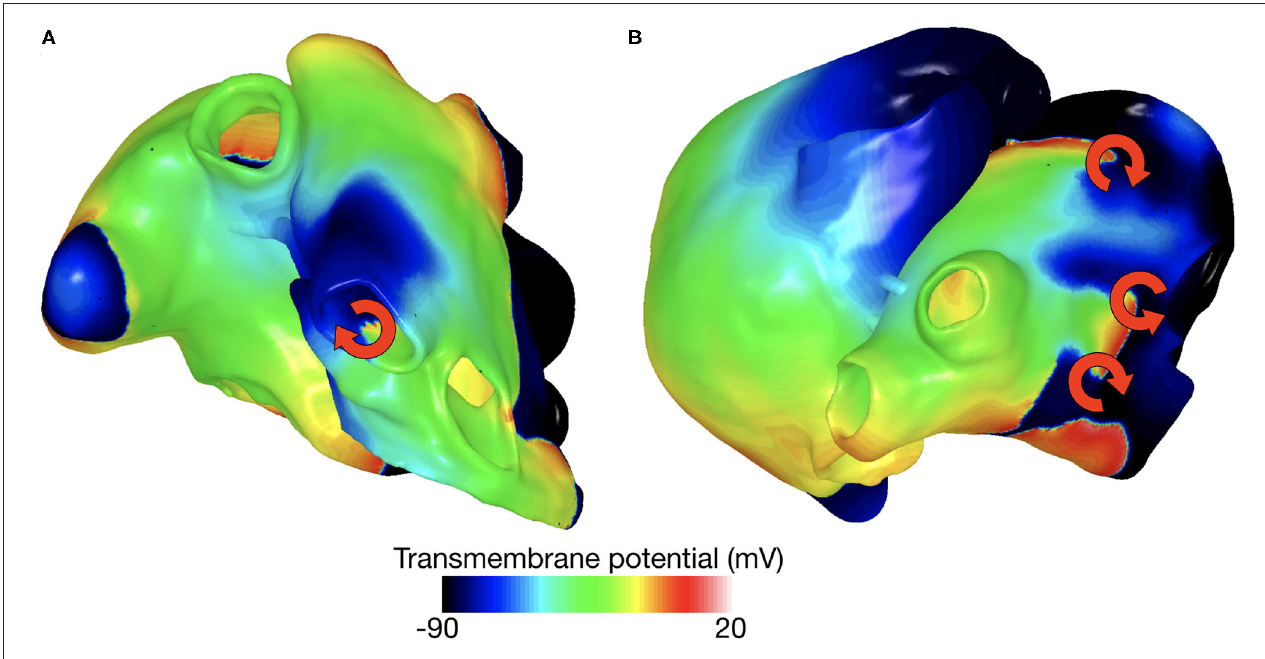
FIGURE 2 | Example of stable llPS (A) and multiple wave fronts (B)